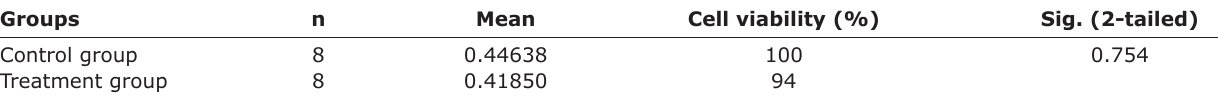
Table-2: Results of independent-sample t-test (The mean optical density values of those two